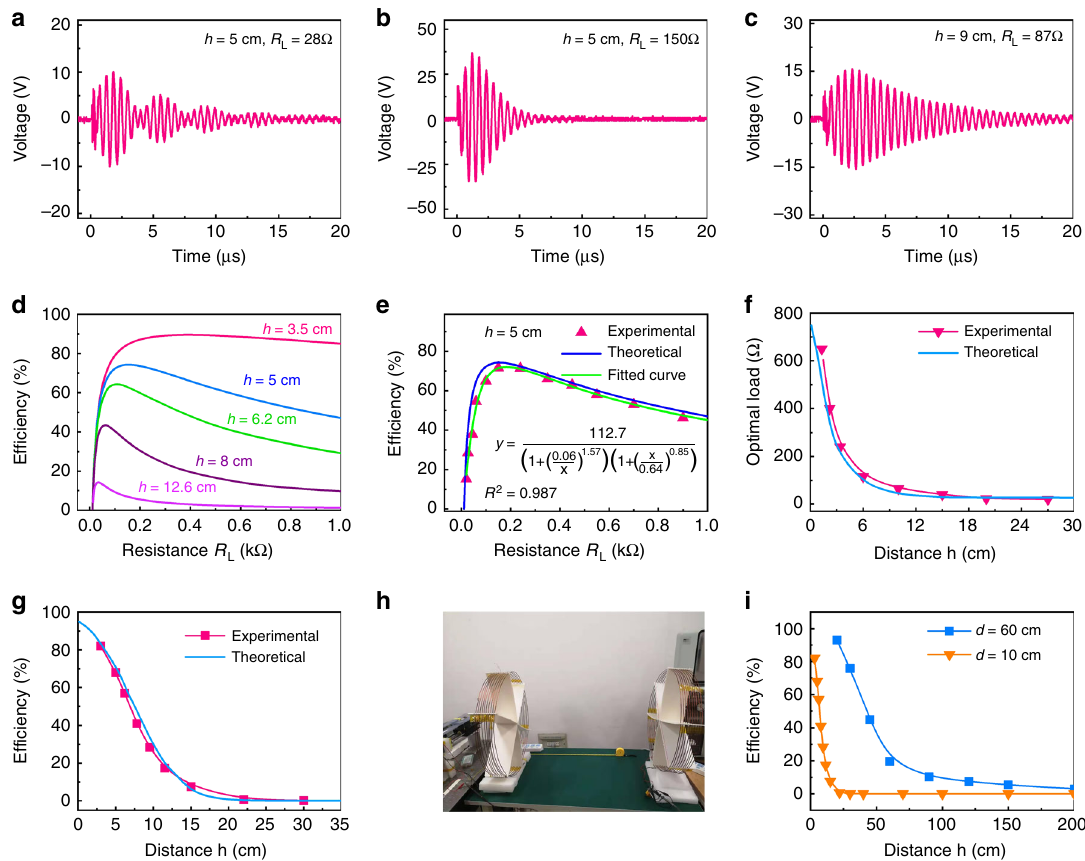
Fig. 3 Effects of load, coil distance, and coil diameter on energy transmission. a , b , c are the received voltage waveforms at different distances between the two coils and different load resistances. d The theoretical calculated energy transmission ef fi ciency of different transmission distances, as a function of load resistance. e The theoretical and experimental energy transmission ef fi ciency (with the distance between the two coils set at 5 cm), as a function of load resistance. f The optimal load resistance and g the energy transmission ef fi ciency of the MR-WTENG system, as a function of distance between the two coils. Here, the diameters of the coils are 10 cm, with an inductance of 62.5 μ H. h The photo of the coils with a diameter of 60 cm for the MR-WTENG system. i The comparison of the transmission ef fi ciency under various distances between the coils with different coil diameters of 10 cm and 60 cm,